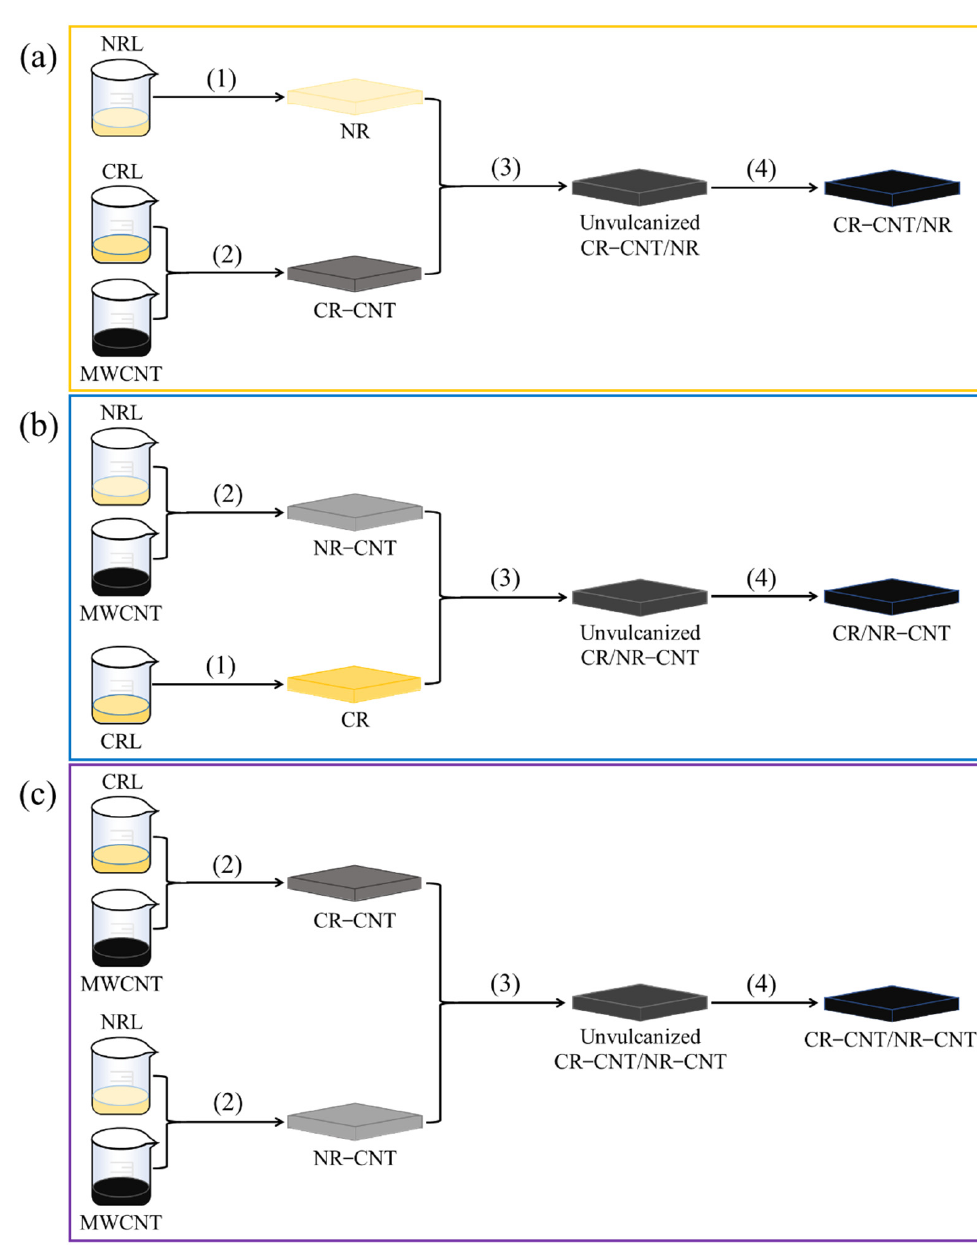
Figure 2. A schematic diagram of the three co-blending processes: ( a ) CR − CNT/NR, ( b ) CR/NR − CNT, and ( c ) CR − CNT/NR − CNT